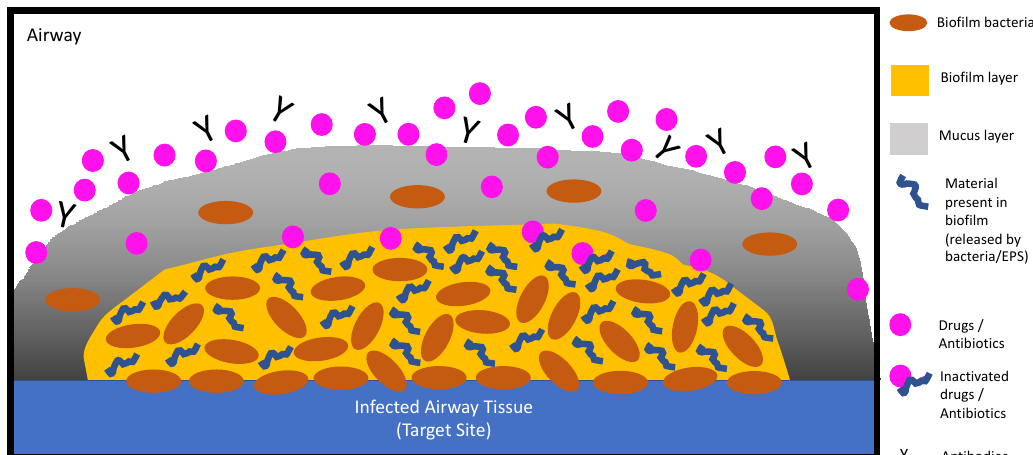
Figure 1. Current therapeutics used are ineffective in penetrating the biofilm layer to reach the target site. In cystic fibrosis (CF), this is further hindered with an additional layer of thick, viscous mucus.